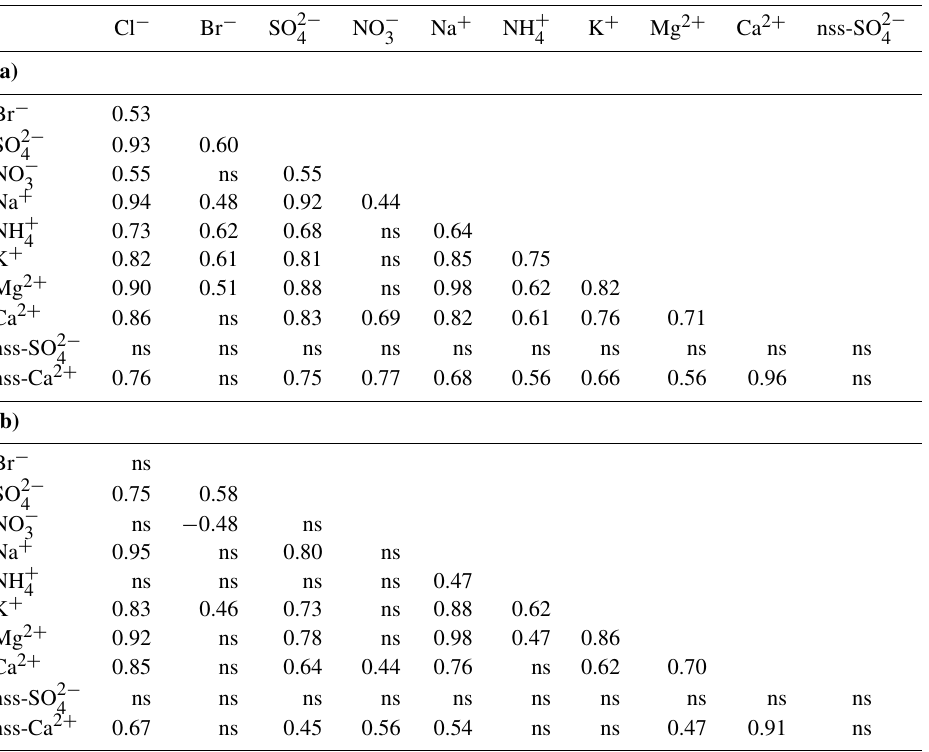
Table 5. Spearman rank order correlations of (a) ionic loads (mgm − 2 ) and (b) SWE-weighted mean concentrations of major ions across all seven glaciers ( n = 22 locations). ns: non-significant correlations ( p value > 0 . 05). Ionic loads were calculated from all snowpit layers, while SWE-weighted mean concentrations were calculated by dividing the total ionic loads in each snowpit by its total SWE. Non-sea-salt / Na + is 0.252 (ww − 1 ; Millero et al., (nss) components were estimated based on seawater ratios: Ca 2 + / Na + is 0.038, while SO 2 − 4